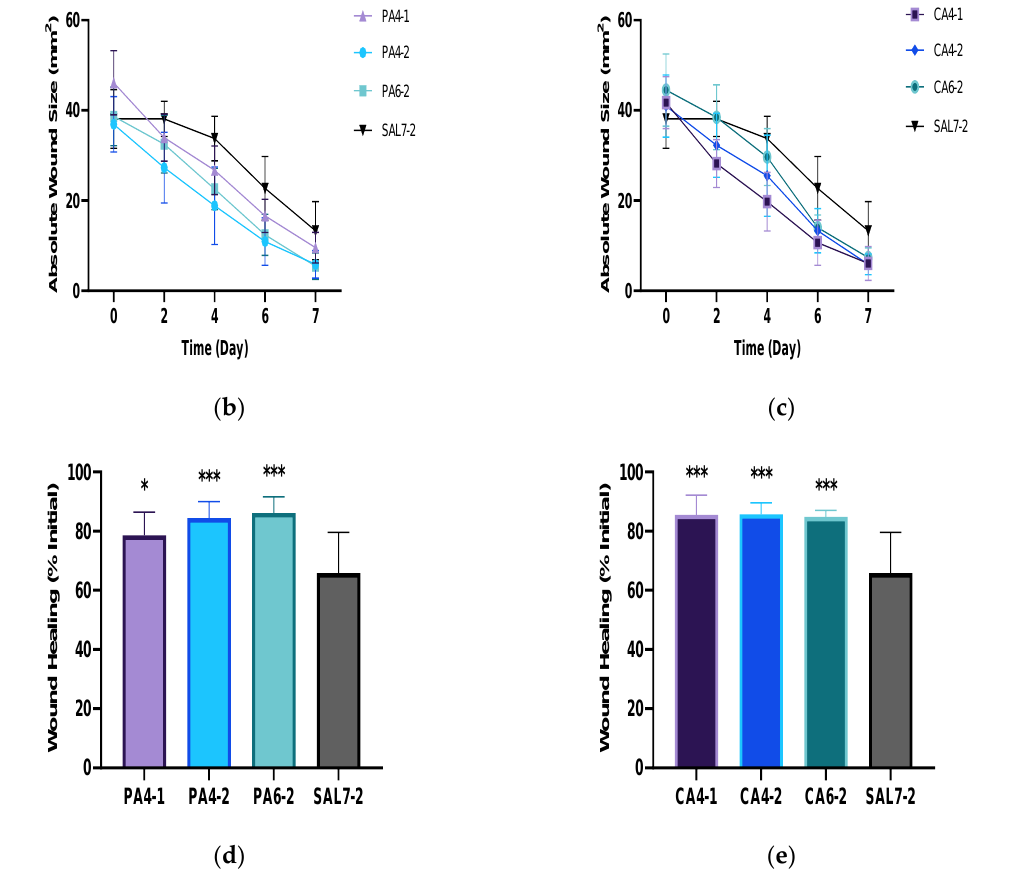
Figure 1. ( a ) Macroscopic evaluation in relation to the time course of gross wound healing after one week of topical application of phosphoric acid (PA) and citric acid (CA) buffer solutions. ( b ) Differences in absolute wound area between phosphoric acid pH 4, once-daily treatment (PA4-1), phosphoric acid pH 4 and 6, once-every-second-day treatment (PA4-2 and PA6-2), and saline control group (SAL7-2). ( c ) Time course of wound regeneration for animal model after dermal treatment with citric acid pH 4, once-daily treatment (CA4-1), citric acid pH 4 and 6, once-every-second-day treatment (CA4-2 and CA6-2) compared with saline control group (SAL7-2). ( d ) Macroscopic wound healing on day 7 when animals were topically applied with phosphoric acid with pH values of 4 and 6, and with different dosing regimens. ( e ) Topical administration of citric acid buffer solutions in comparison to saline as control group at day 7 post-treatment. Each bar represents mean ± standard deviation. * p < 0.05 and *** p < 0.001 indicates the results obtained were statistically significant from control group (SAL7-2).